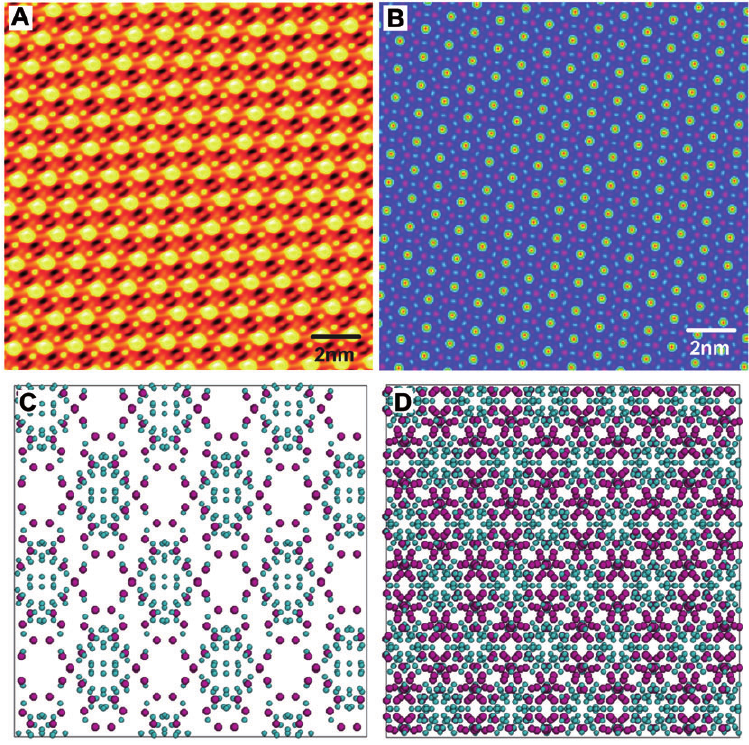
Figure 14 HREM images of [Na camera, after image processing. Projected structure models along (C) [110] and (D)